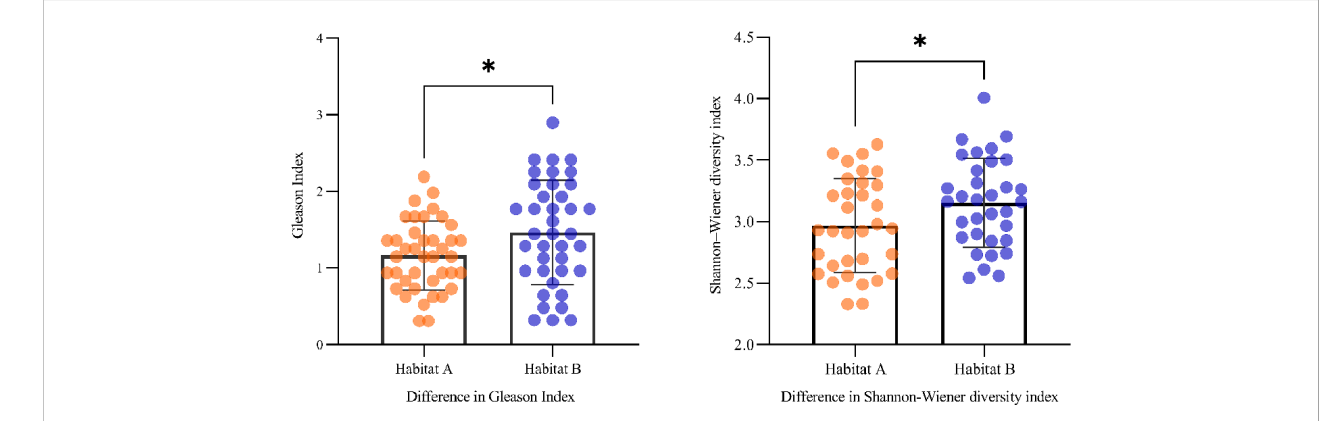
FIGURE 4 Variability of different diversity indices in different habitat patterns (*P <